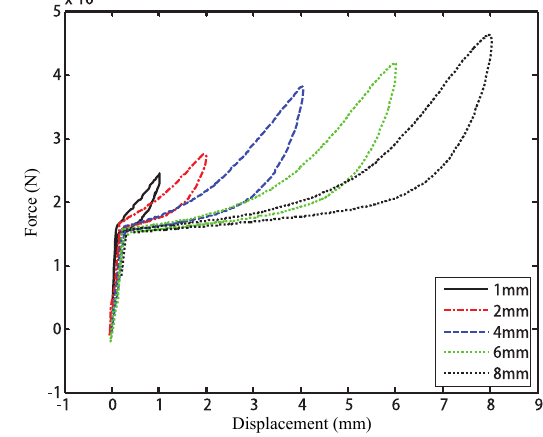
Fig. 7. Hysteresis curves under 0.5 Hz with various amplitude excita-